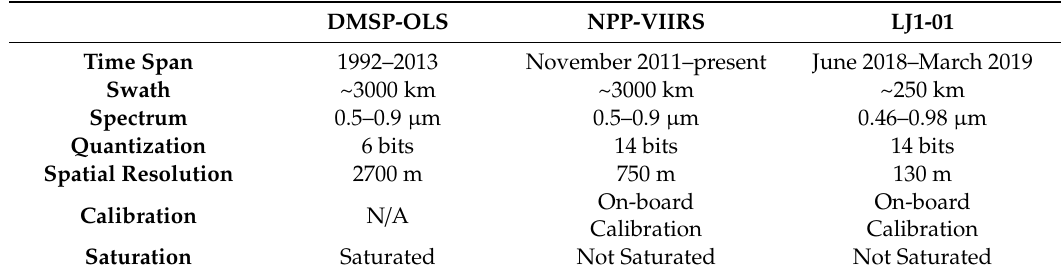
Table 1. Specifications of the three types of nighttime light (NTL)